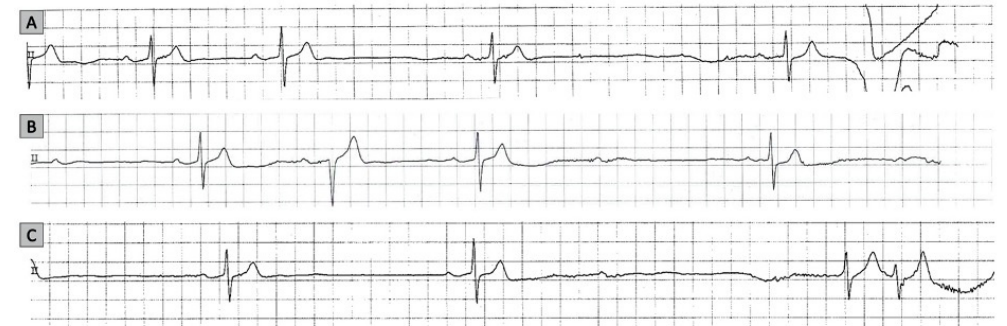
Figure 3. Cardioinhibitory response recorded on telemetry in a patient with neurally mediated syncope. Progressive slowing of sinus rate and first-degree atrioventricular (AV) block (panel ( A )), and two episodes of second-degree AV block (panels ( B , C )). The association of sinus bradycardia and different types of AV block is highly suggestive for a vagal mechanism for syncope.